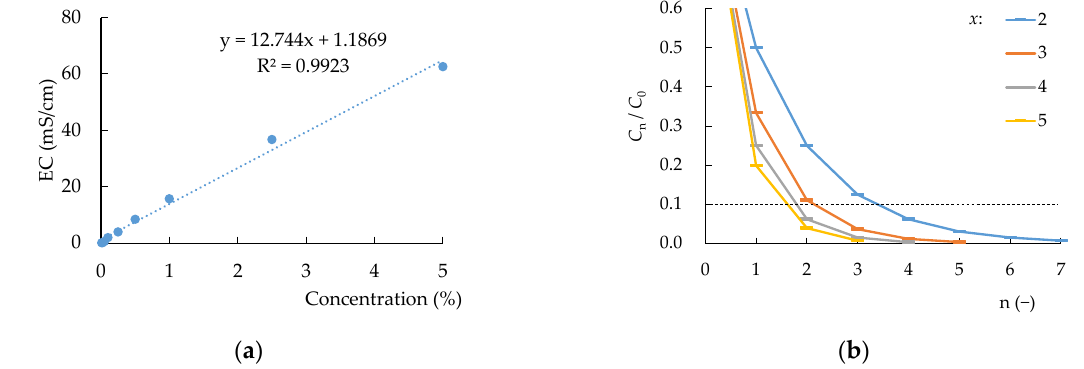
Figure 11. ( a ) Relationship between concentration and electrical conductivity of calcium chloride solution. ( b ) Theoretical relationship between the number of dilutions and concentration ratio in the bottle method. Table 3. The ratio of actual concentration to theoretical concentration for dilution of flotation medium by the bottle method (n = 1).